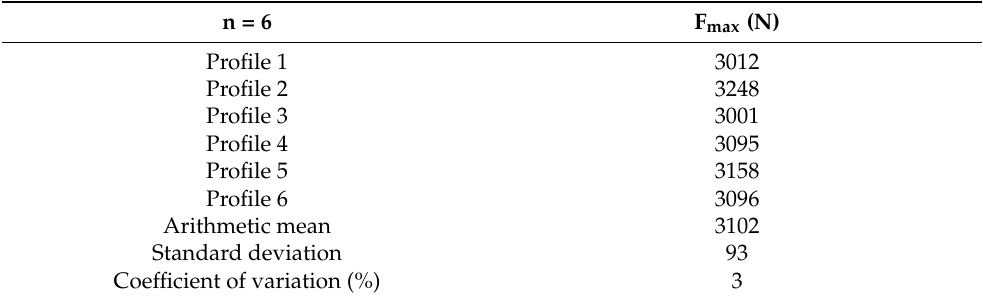
Results comparison of the maximum load force on the buckling test of hollow composite profiles.